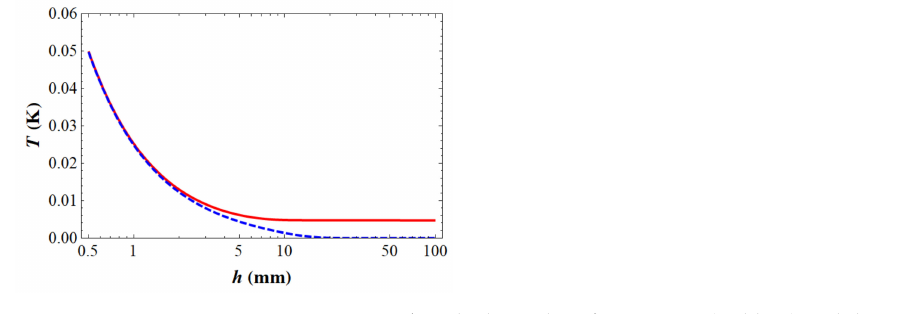
Figure 15. Temperature increase versus h at the heated surface at z = 0 (red line) and the non-heated surface z = h (blue dashed line) of the supporting float glass. t exp = 100 s is fixed.